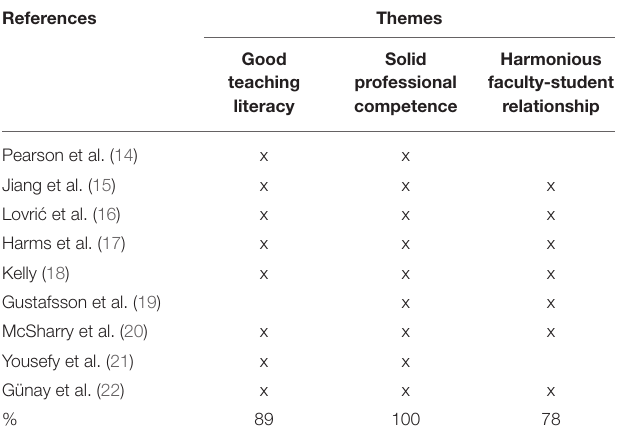
TABLE 3 | The effect size of